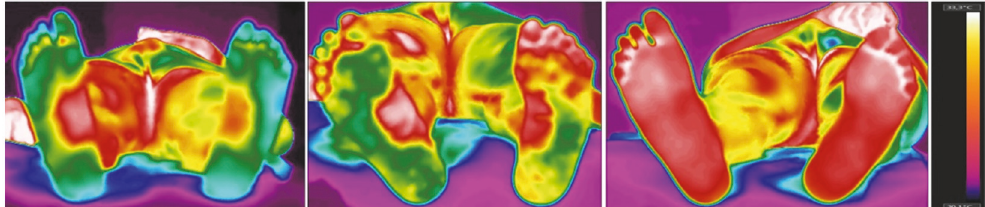
Figure 3: Thermographic image of the plantar cutaneous region at baseline, immediately after the robotic training, and 30 minutes after the end of the robotic training (from left to